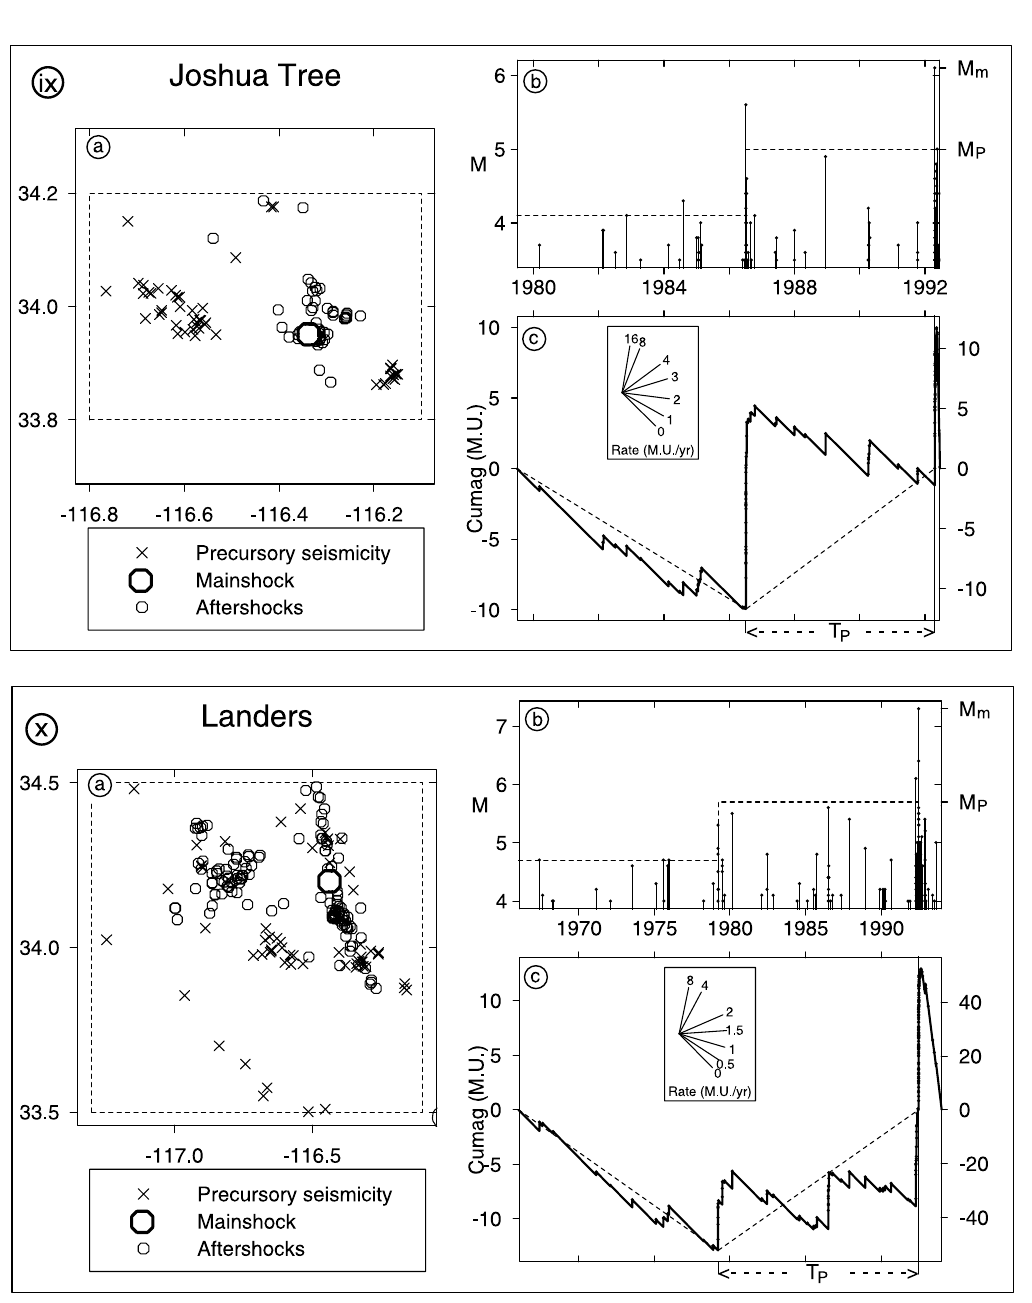
Fig. 3ix,x. (cid:115) -phenomenon: data and interpretation for major earthquakes at (ix) Joshua Tree and (x) Landers. For explanation see caption fig.